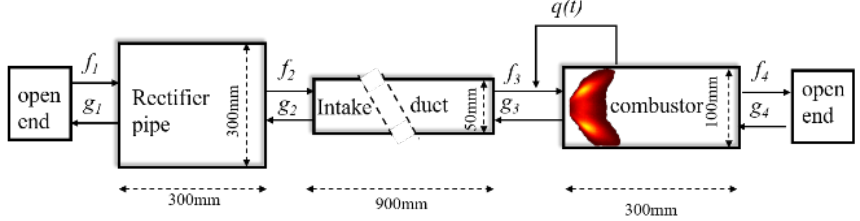
Figure 4. LOTAN of model combustor experimental system.